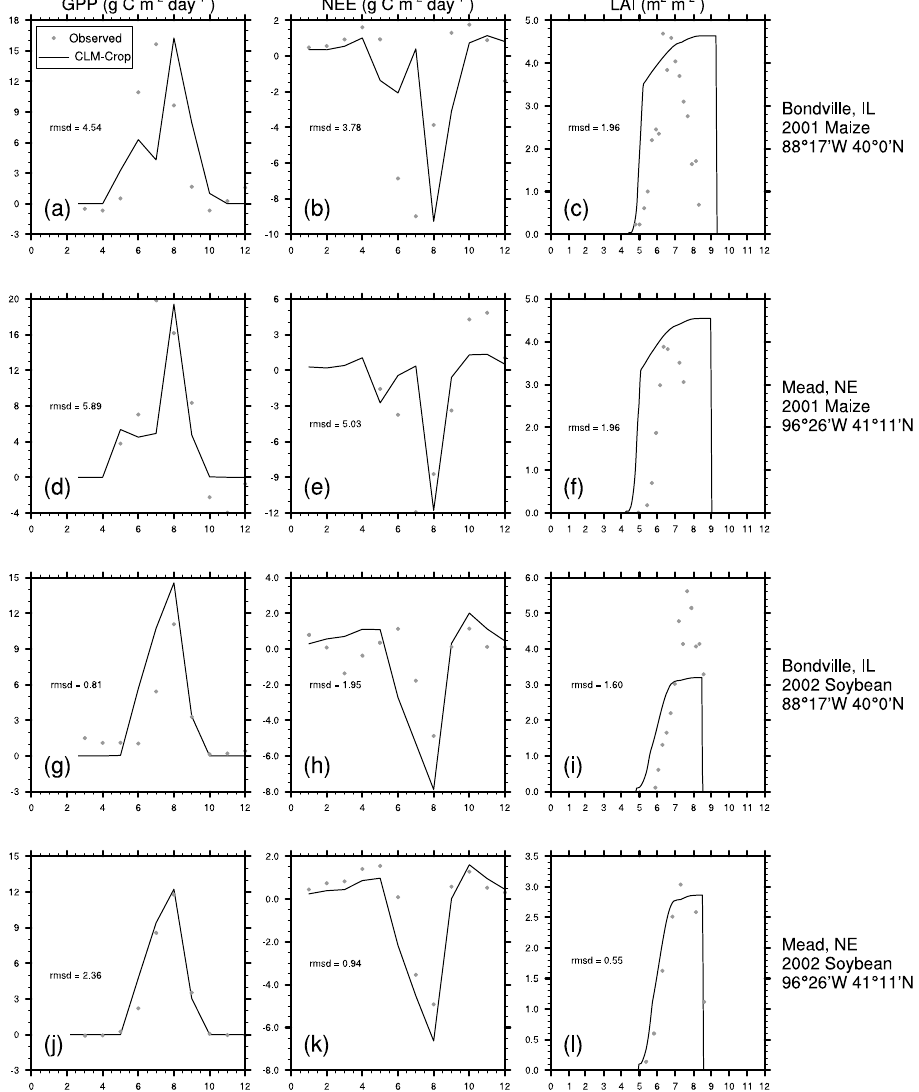
Fig. 2. Simulated (lines) and observed (circles) monthly averaged gross primary productivity (GPP; gCm − 2 day − 1 ) , net ecosystem exchange (NEE; gCm − 2 day − 1 ), and LAI (m 2 m − 2 ) during 2001 and 2002 for maize and soybean at two sites: Bondville, IL (40.01 ◦ N, 88.29 ◦ W), and Mead, NE (41.18 ◦ N, 96.43 ◦